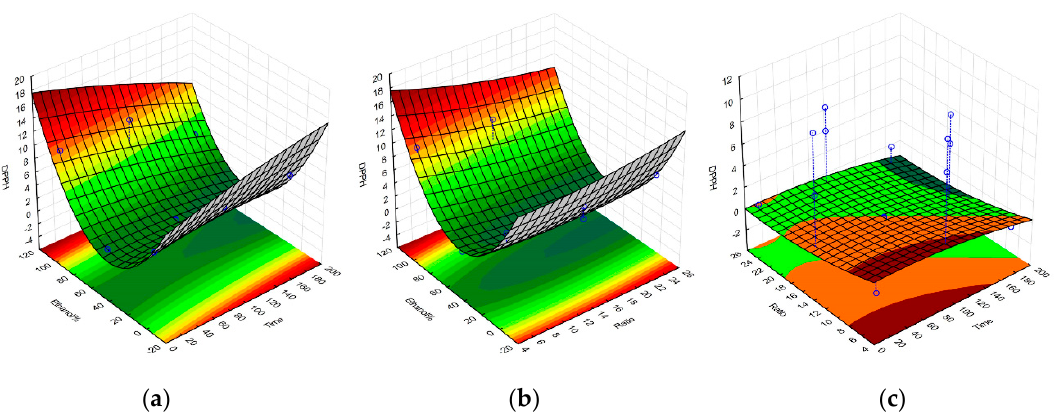
Figure 1. Response surface graphs for the model of the G. gracilis extractions, obtained for the 2,2-diphenyl-1-picrylhydrazyl (DPPH) response upon variation of ethanol% and extraction time ( a ), ethanol% and solid-to-liquid ratio ( b ), and solid-to-liquid ratio and extraction time ( c ). DPPH radical reduction activity expressed in mg of trolox equivalents per g of dried extract. Time is expressed in minutes, and solid-to-liquid ratio (SLR) (here displayed as Ratio) as solvent volume (mL) per one gram of dried seaweed.